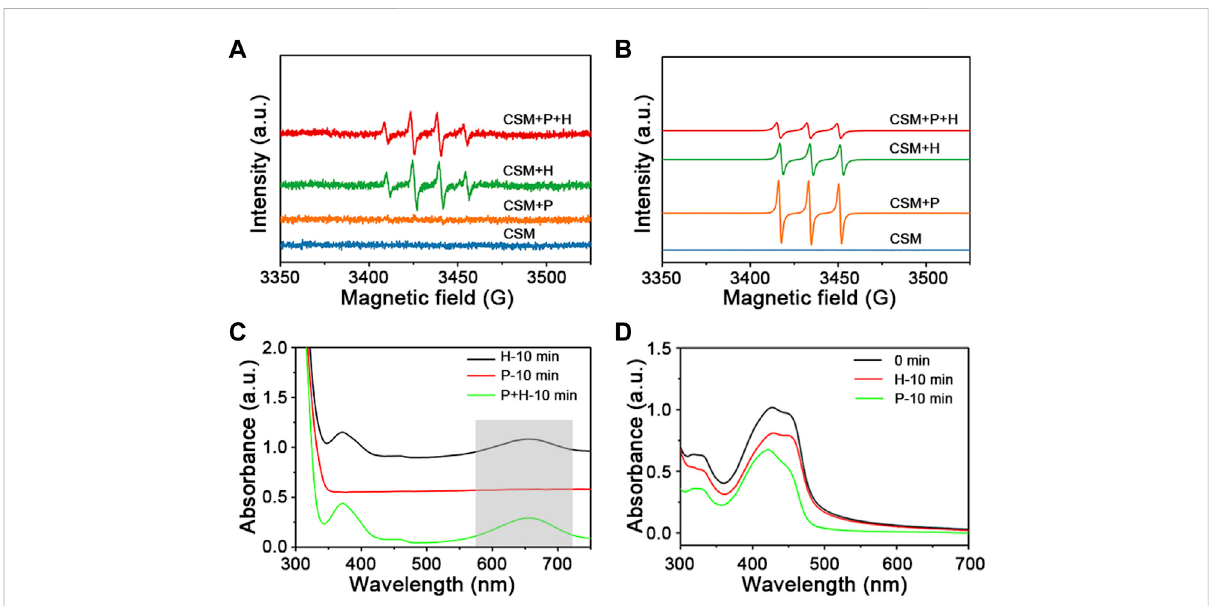
FIGURE 6 (A) EPR spectra of radical adduct trapped by DMPO- (B) EPR spectra of radical adduct trapped by TEMPO- 1 O 2 . (labelled as “ CSM + H ″ , “ CSM + P ″ , and “ CSM + P + H ″ ). (C) UV − Vis spectra measuring of TMB in a reaction system with H 2 O 2 and visible light over Cu 2 O@SiO 2 /MnO 2 − PEG. (D) UV − Vis spectra measuring of DPBF with H 2 O 2 or visible light